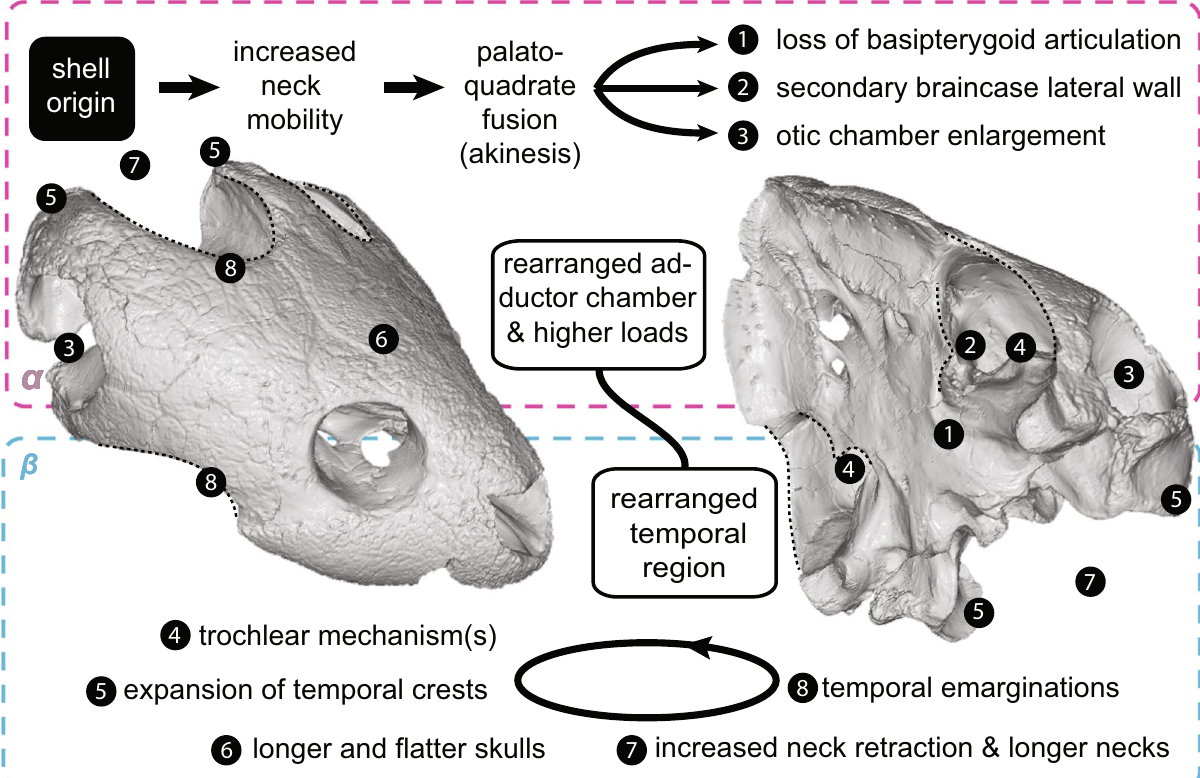
Figure 5. Hypothesis of progressive correlation between neck and head during turtle evolution. The origin of the turtle shell initiates the first selective regime ( α ) in which muscle rearrangements enable more flexible necks that overcome the lack of mobility of the shelled body, but also exert distinct compression and tension loads on the skull. This is compensated by an increasing stiffness (through palatoquadrate fusion, closure of basipterygoid region (1), secondary braincase lateral wall (2) formation). The new, stiffened skull architecture can withstand higher loads at the same time allowing material reduction in the temporal region, opening the path to a second selective regime ( β ). Longer and flatter skulls (6) evolve, together with posterior expansion of temporal crests (5) and the enlarged otic chamber (3), both features reducing available volume inside the adductor chamber and triggering the appearance of a trochlear mechanism (4). Broader insertion sites for neck musculature offered by expanded temporal crests (5) support a new round of neck modifications, resulting in longer necks and modern types of neck retraction (7). Temporal emarginations (8) evolve in response to new forces generated by more powerful neck musculature. Model of † Eubaena cephalica as in Supplementary Fig.